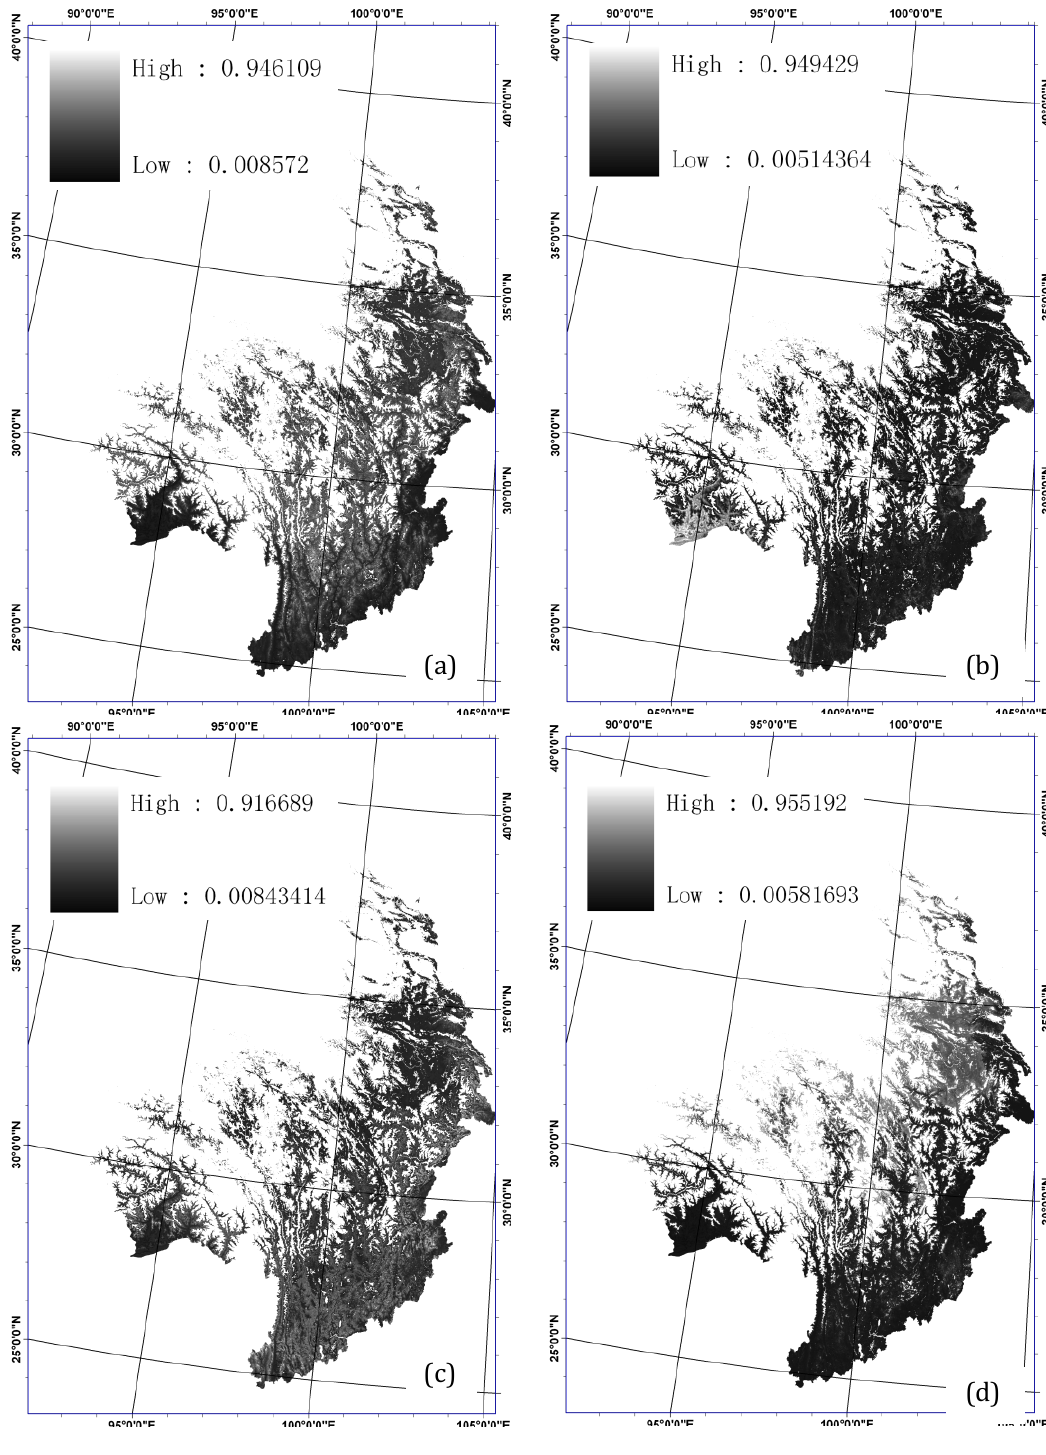
Figure 4. Normalized distance between reference mean vector and candidate pixels of Category4: ( a ) evergreen broad leaf trees; ( b ) evergreen needle leaf trees; ( c ) deciduous broad leaf trees; ( d ) shrub; ( e ) cereal crop and ( f ) broad leaf crop in category4; ( g ) grass and ( h )